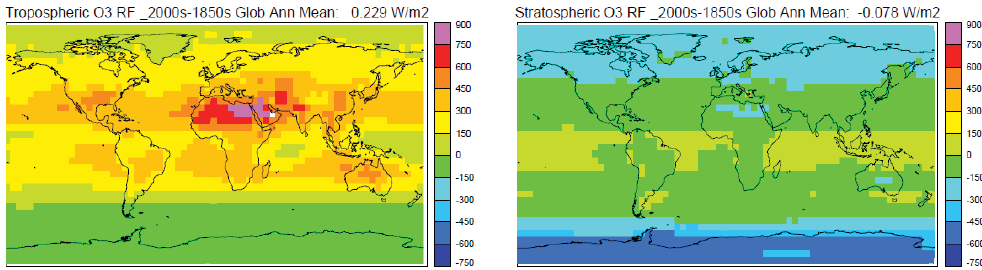
Fig. 15. Ozone radiative forcings (mWm − 2 ) at the tropopause (after stratospheric temperature adjustment) for the 2000s, relative to the 1850s, for (a) tropospheric ozone and (b) stratospheric ozone.